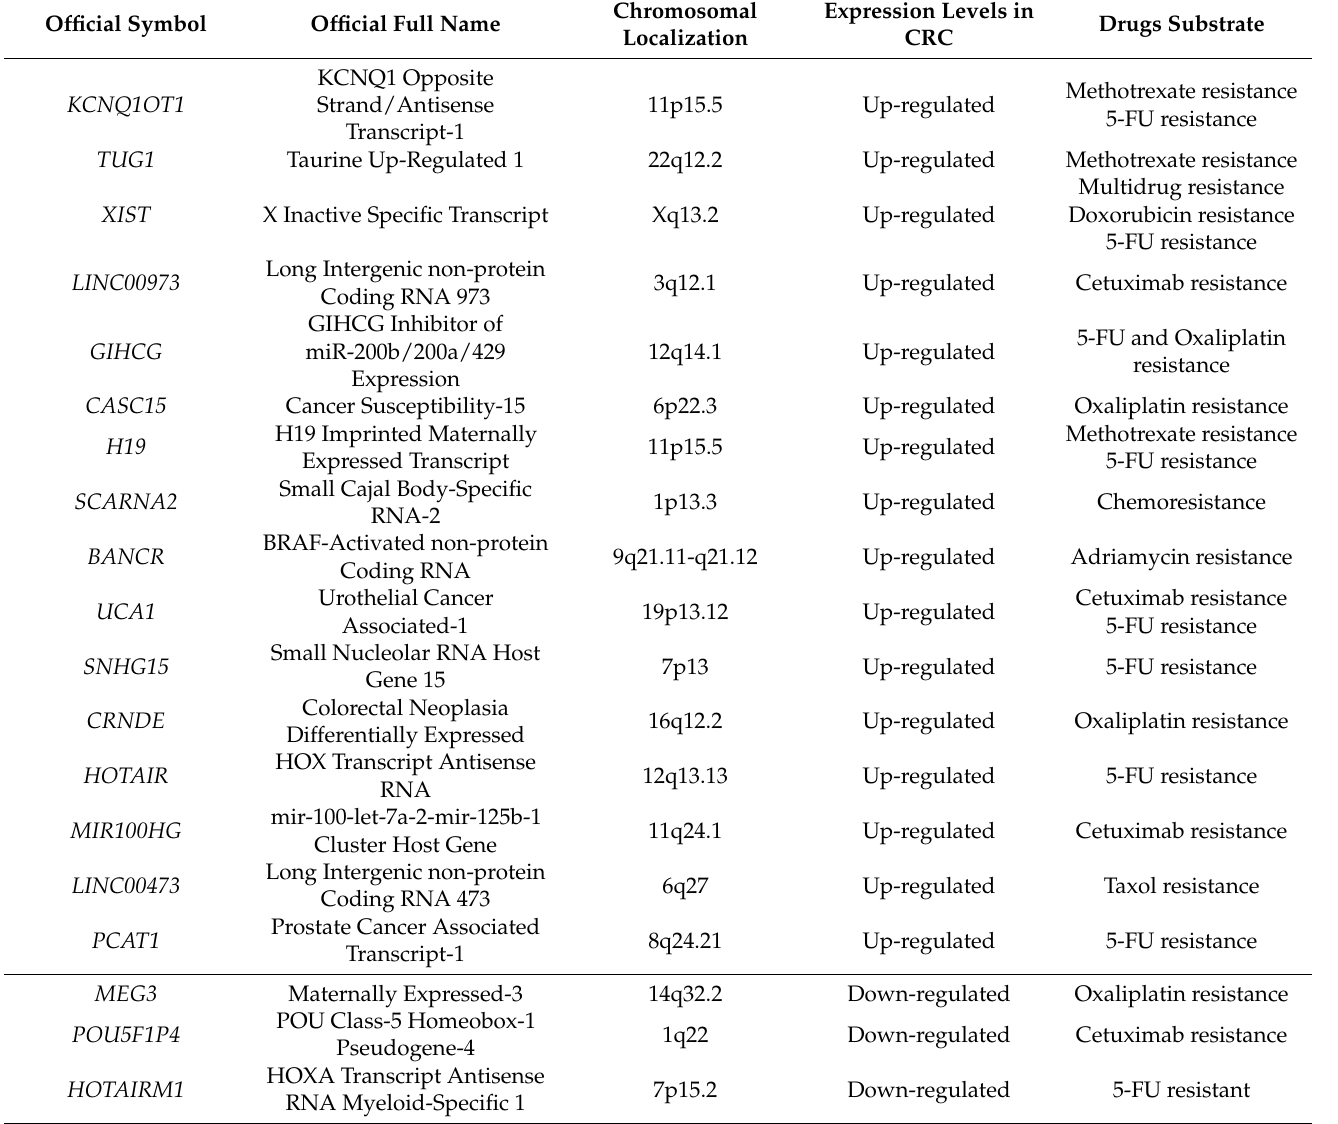
Table 1. LncRNAs involved in CRC